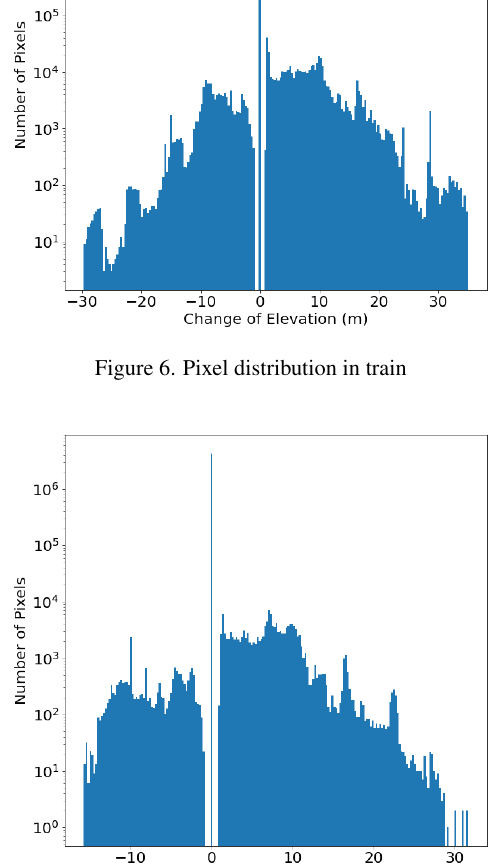
Table 1. Main features of the data contained in the proposed